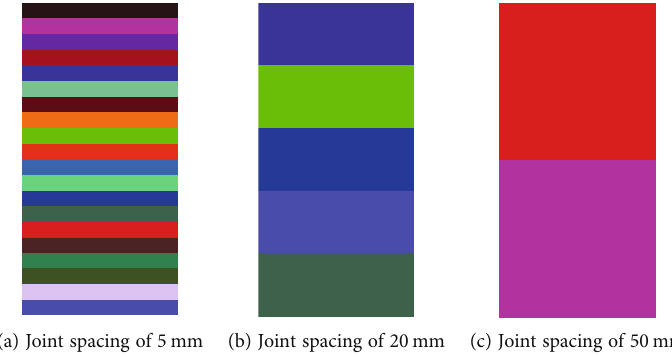
Figure 12: Diagram of di ff erent joint